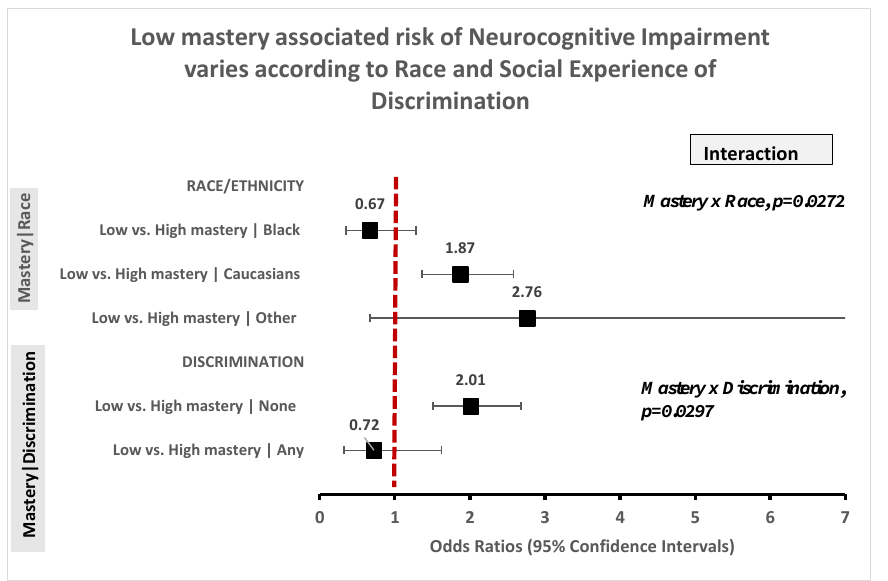
Figure 3. Low mastery associated risk of Neurocognitive impairment varies within strata of race, and social experience of